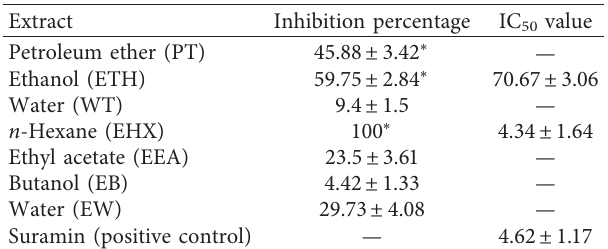
Figure 5: (a) Rat aortic ring assay. Rings were treated by ethanol ( − ve), A. lappa extracts (100 μ g/mL), or Suramin (100 μ g/mL) (+ve). Microvessel outgrowth was measured by ImageJ software. Magnification is 4x. (b) Percentage of inhibition of microvessel outgrowth after treatment. Values are mean ± SD. ∗ p < 0.05. (c) Percentage of inhibition of VEGF-A after EHX treatment (15 and 30 μ g/mL). Values are mean ± SD. ∗ p < 0.05. Table 3: Rat aorta ring assay percentage of inhibition at 100 μ g/mL of extracts and the IC 50 values ( μ